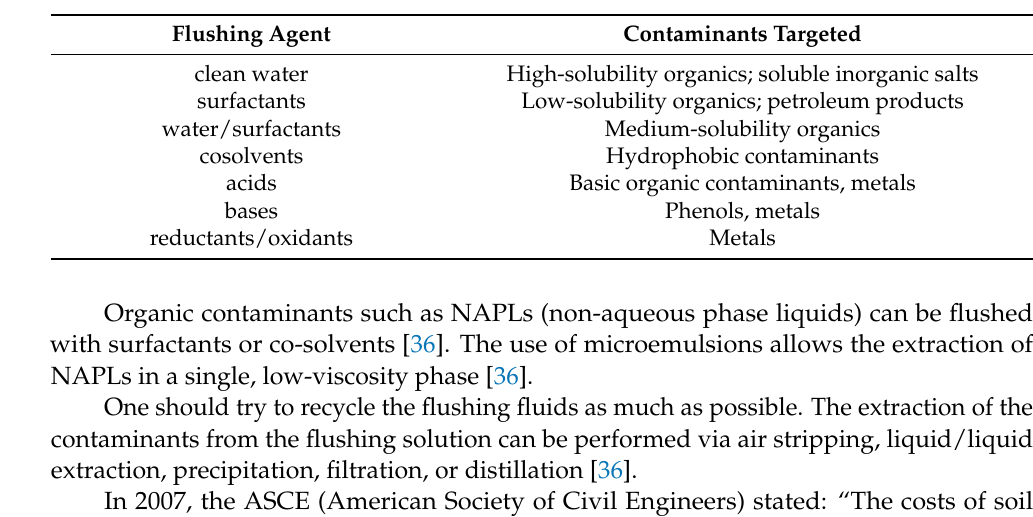
Table 1. Types of flushing agents for soil. Source: [10].